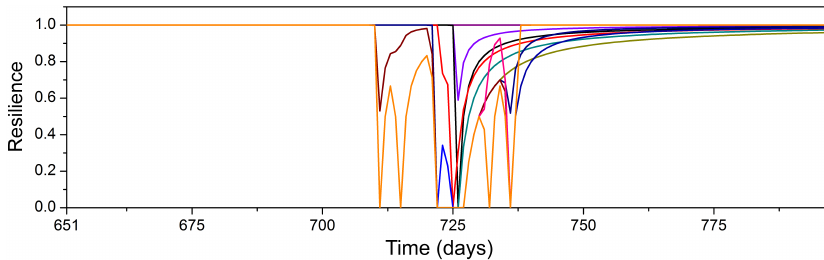
Figure 3. Temporal variation of resilience to irrigation water scarcity.